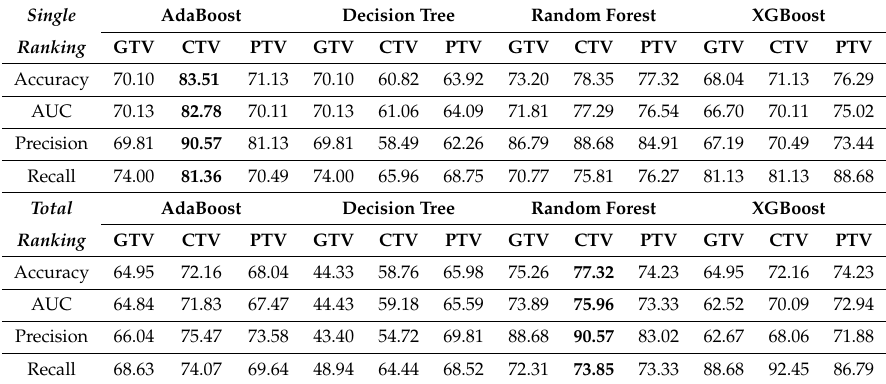
Table 3. System performance in all possible combinations. The upper panel refers to the single ranking strategy for feature selection, whereas the lower panel shows the results considering the total ranking